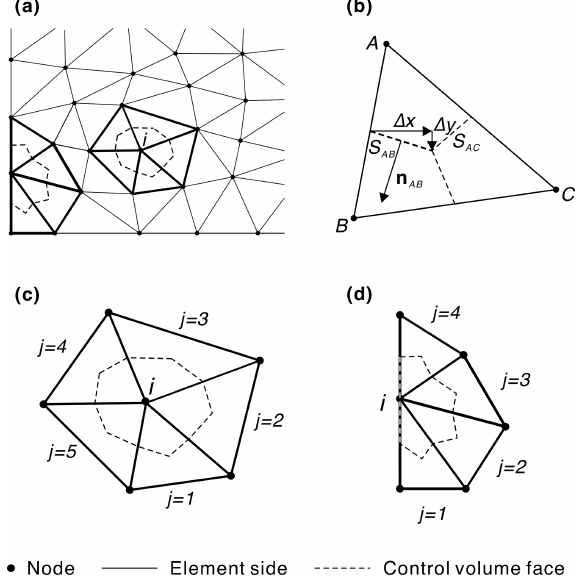
Figure 3. Global and local mesh geometry: (a) the discretized do- main and elements, (b) a triangular element divided by the seg- ments connecting the centroid and the midpoint of each side, (c) the control volume and the region of support of an internal node, and (d) those of a node on the